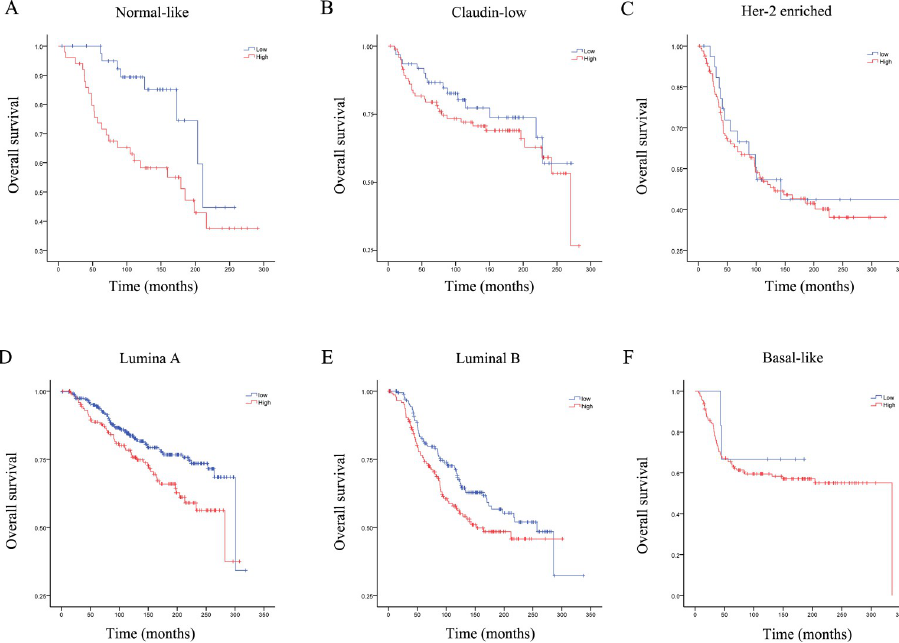
Fig 6. The effect of RRM2 expression on the overall survival of breast cancer patients with different molecular subtypes. We found that in Luminal A and Normal like breast cancers, the High RRM2 expression group had poor overall survival. (A) Normal-like; (B) Claudin-low; (C) Her-2 enriched; (D) Luminal A; (E) Luminal B; (F) Basal-like.